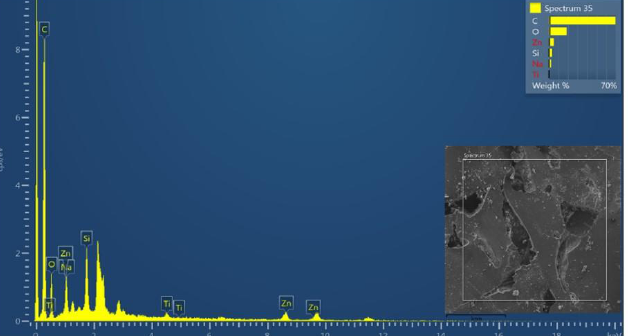
Figure 10. EDS mapping of TiO 2 (2 g) immobilization on black rubber substrate (100×) in the third layer.